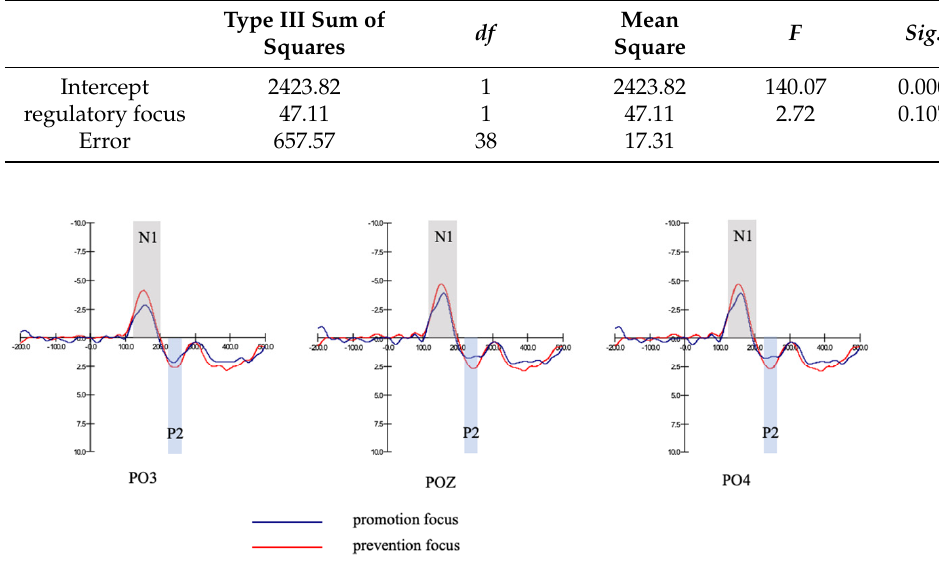
Figure 2. N1, P2 amplitudes of different regulatory focus types.